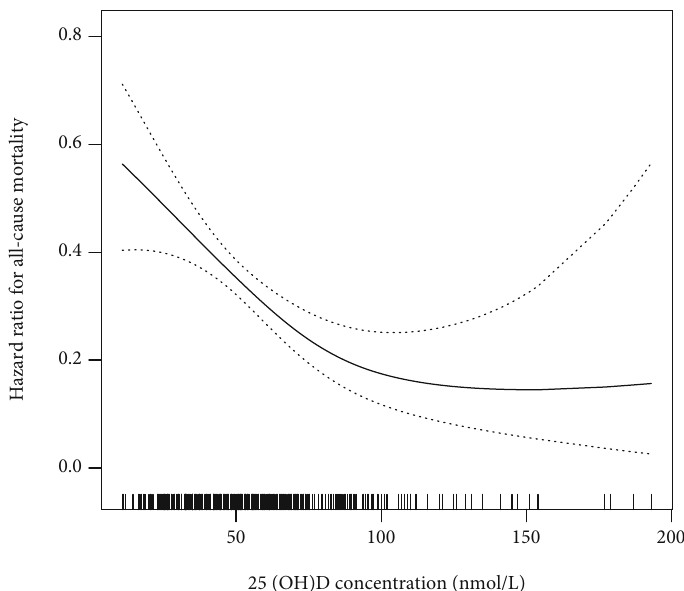
Figure 1: The association between vitamin D level and all-cause mortality. A nonlinear relationship between them was detected after adjusting for age, sex, race, BMI, education levels, family income-poverty ratio, glucose, glycohemoglobin, total cholesterol, HDL, LDL, triglyceride, creatinine, and blood urea nitrogen. The solid line and dashed line represent the estimated values and their corresponding 95% con fi dence intervals.